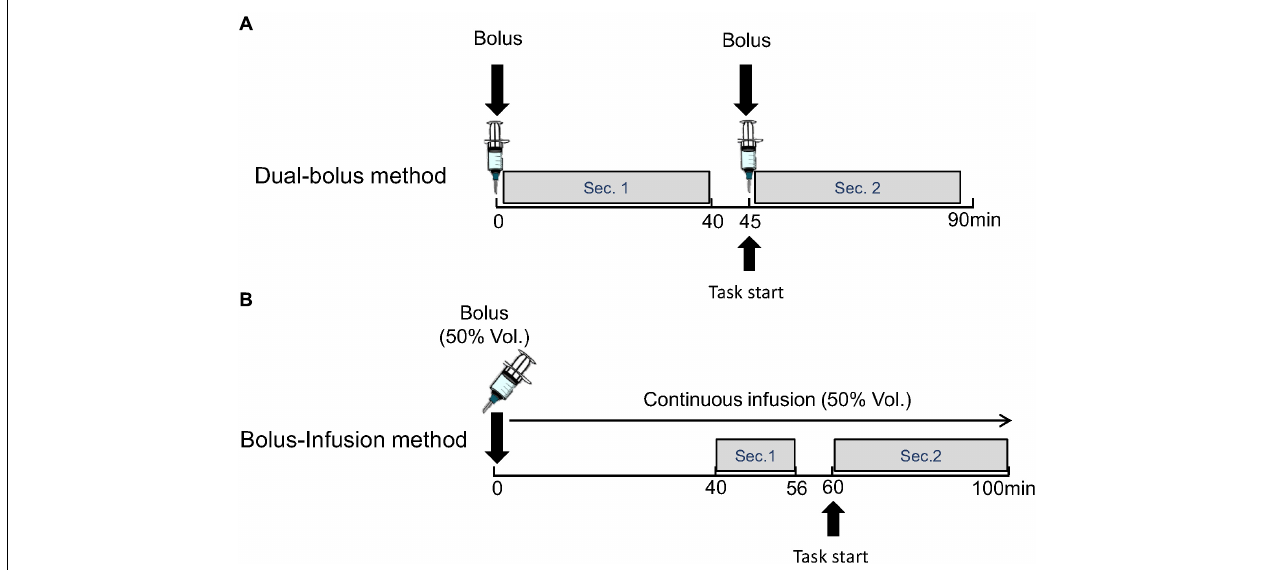
FIGURE 2 | Protocol of proposed dual-bolus injection method (A) and conventional bolus-plus-continuous infusion method (B) . Binding potentials were estimated using frames before the stimulation (Sec. 1) and after the stimulation (Sec.